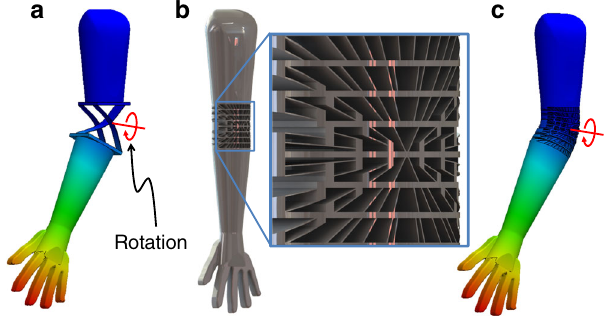
Fig. 1 Introduction to directionally compliant metamaterials (DCMs). a A fl exure system that exclusively achieves the desired rotational degree of freedom (DOF) of an elbow but fails to assume its shape and, b an aperiodic DCM that can be shaped to conform to any elbow shape while also achieving high stiffness in all directions except about, c , the